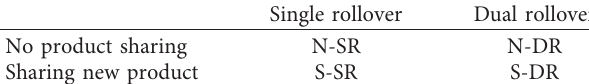
Table 1: Four business strategy